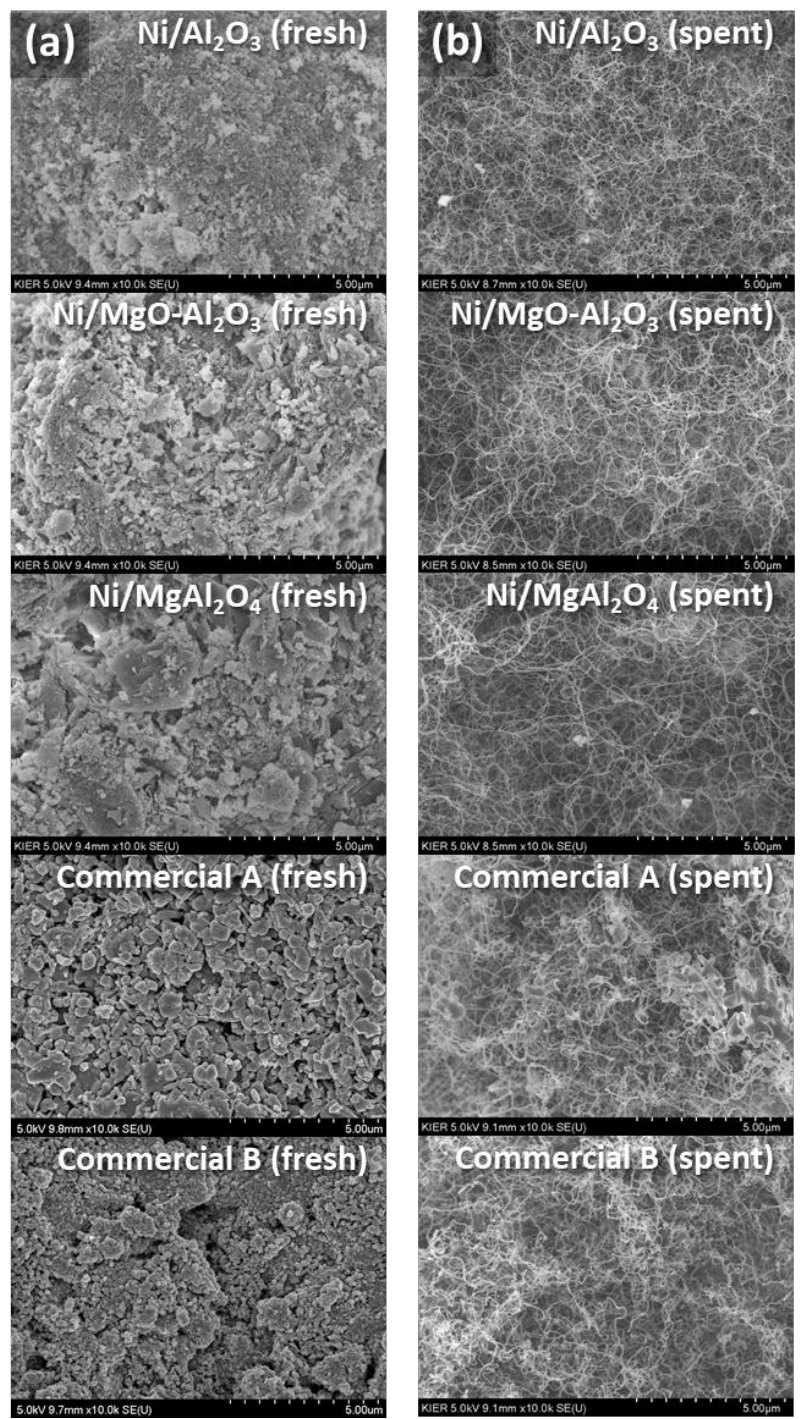
Figure 6. SEM images of fresh ( a ) and spent ( b ) catalysts with various supports (reaction conditions: Temp. = 600 °C, CH 4 /CO 2 /N 2 = 1/1/1, GHSV = 144,000 mL/g cat ∙h, TOS = 20 h).